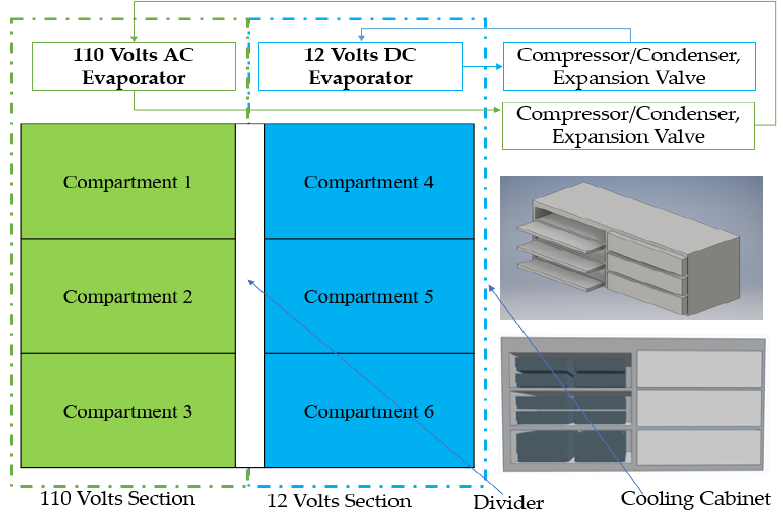
Figure 1. Conceptual design and 3D model of the lab-scale hybrid oyster refrigeration system.